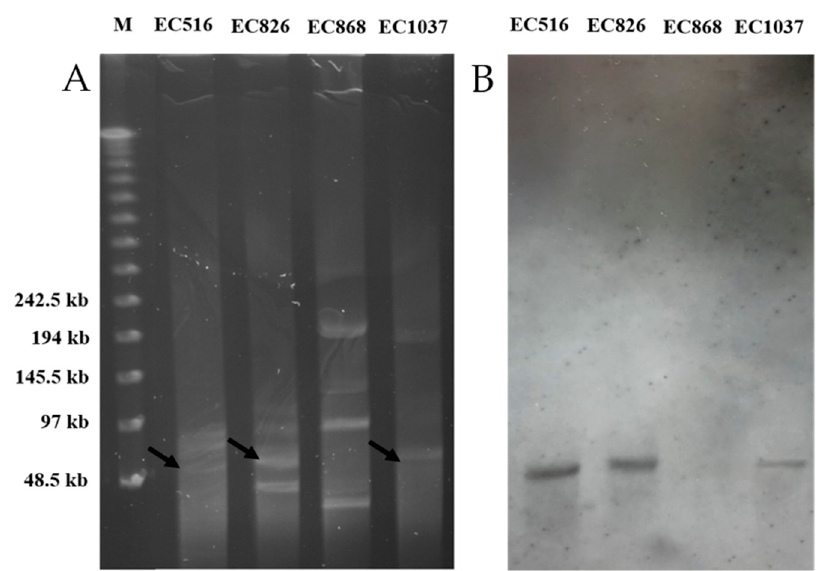
Figure 2. ( A ) S1 nuclease PFGE patterns of plasmids from four clinical isolates. ( B ) the Southern blotting pattern (“M” indicates the lambda molecular weight marker, arrows indicate hybridized plasmids which were shown with positive signals by Southern blot hybridization with the probe).